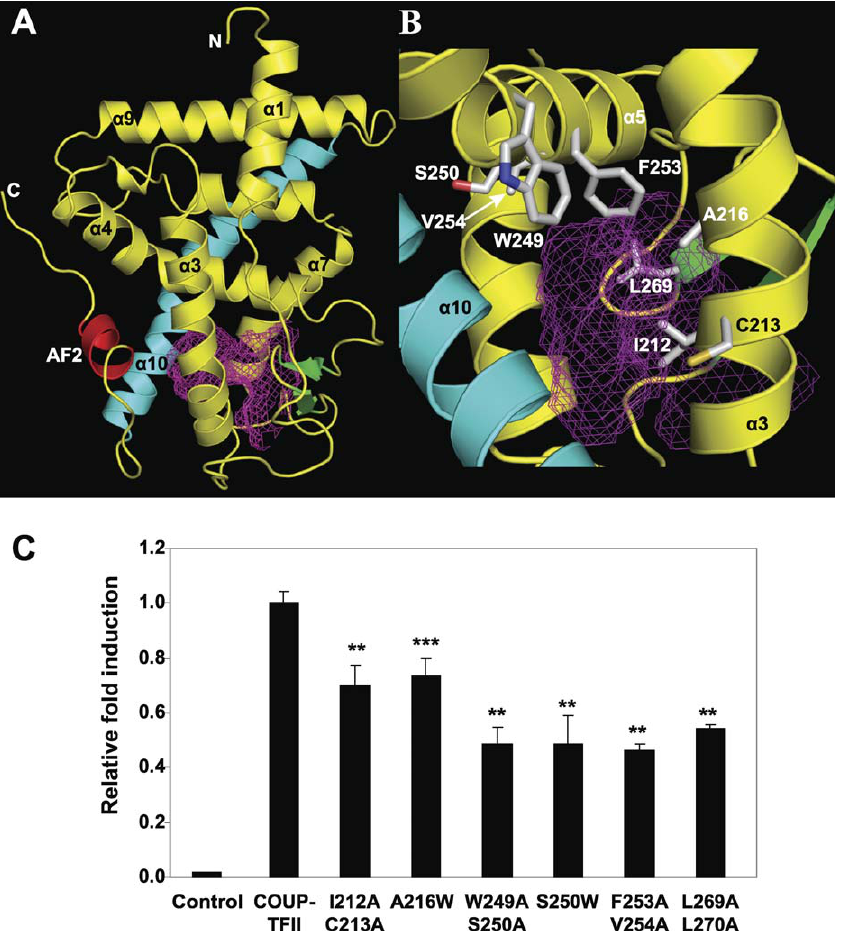
Figure 5. An Intact Pocket Is Important for COUP-TFII Activation (A) An active model of COUP-TFII. This model is based on the agonist-bound RXR structure with its helix a 10 (cyan) extended and AF2 (red) in the active conformation. One cavity (magenta) with size of 659 A˚ 3 is found in this conformation. (B) The potential ligand binding pocket (magenta mesh) in the active model of the COUP-TFII LBD and its surrounding residues. (C) Effects of pocket residue mutations on COUP-TFII activation. The relative fold of activation by the wild-type receptor is set to 1. The statistical analysis for the fold induction of the mutants was compared with wild-type COUP-TFII.